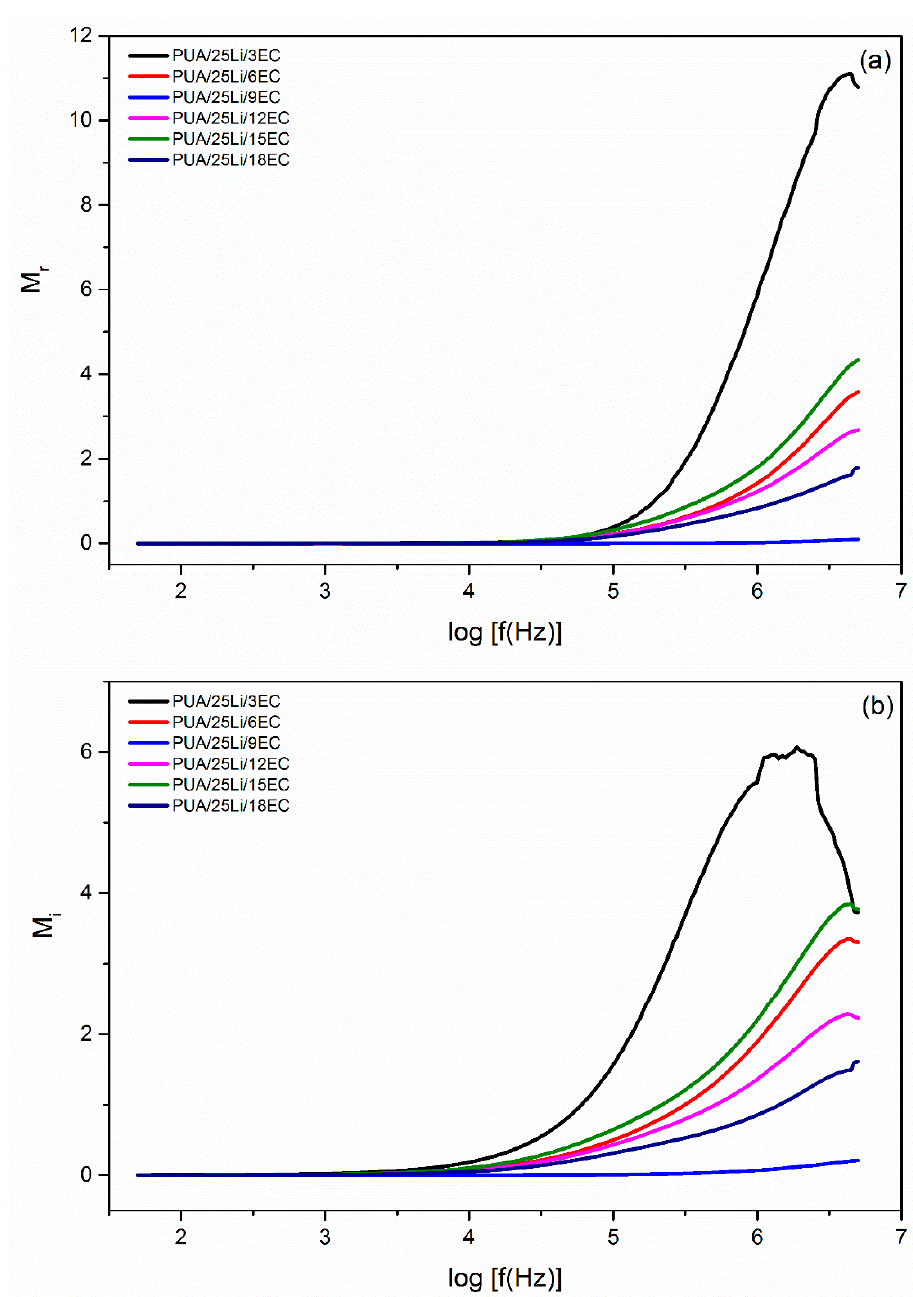
Figure 8. Variation of ( a ) real electrical modulus ( M r ) and ( b ) imaginary electrical modulus ( M i ) of PUA/LiClO 4 /EC electrolytes.